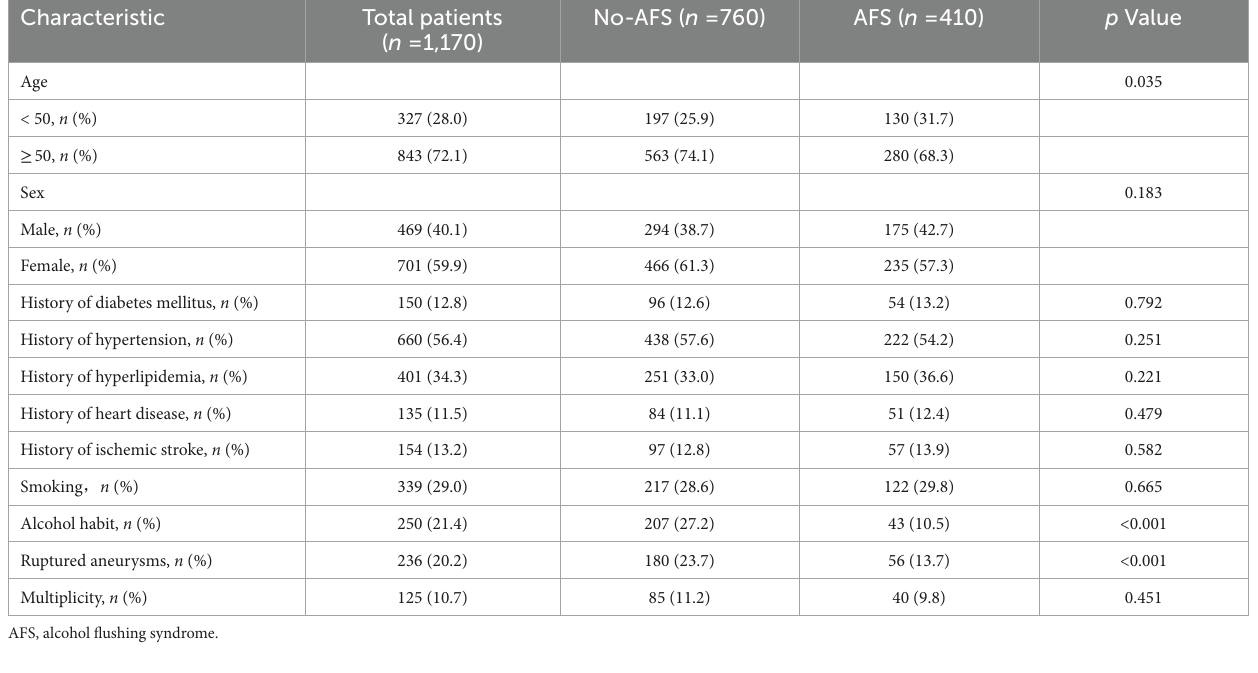
TABLE 4 Clinical characteristics of patients grouped according to presence of alcohol flushing syndrome. Characteristic